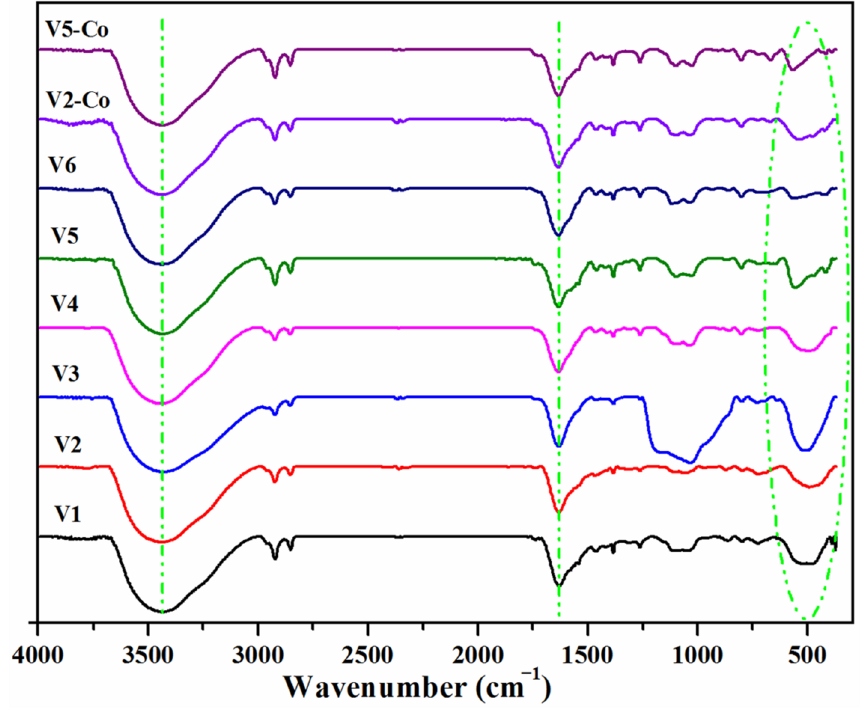
Figure 1. FTIR spectra of CeO 2 nanoparticles prepared using various synthesis methods.